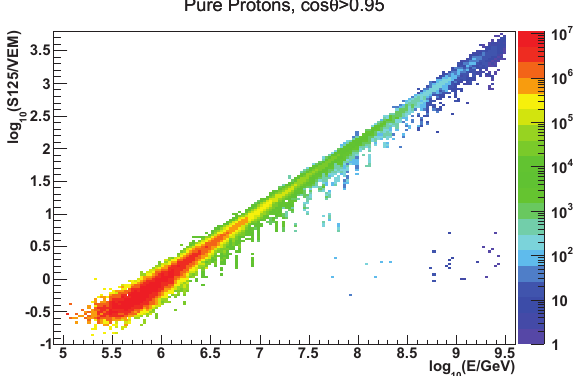
Figure 3: Correlation between S 125 and primary energy in IceTop for proton simulations [5] using Sibyll2.1